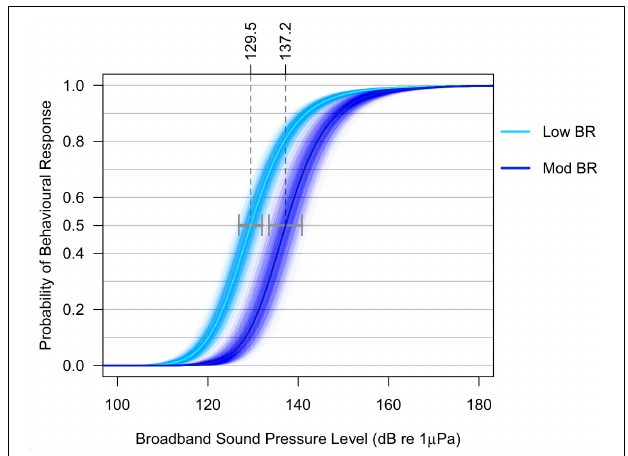
FIGURE 2 | Simulated dose-response curves for low and moderate severity responses. Variability in the dose-response relationship was included in the noise-exposure model as seen in this figure. The 95% CI are shown as gray horizontal error bars at 50% probability of a Low and Moderate (Mod) behavioral response (BR), and are derived from a regression equation of northern and southern resident killer whales responding to commercial vessel noise (see Supplementary Figures and Supplementary Methods for more details on